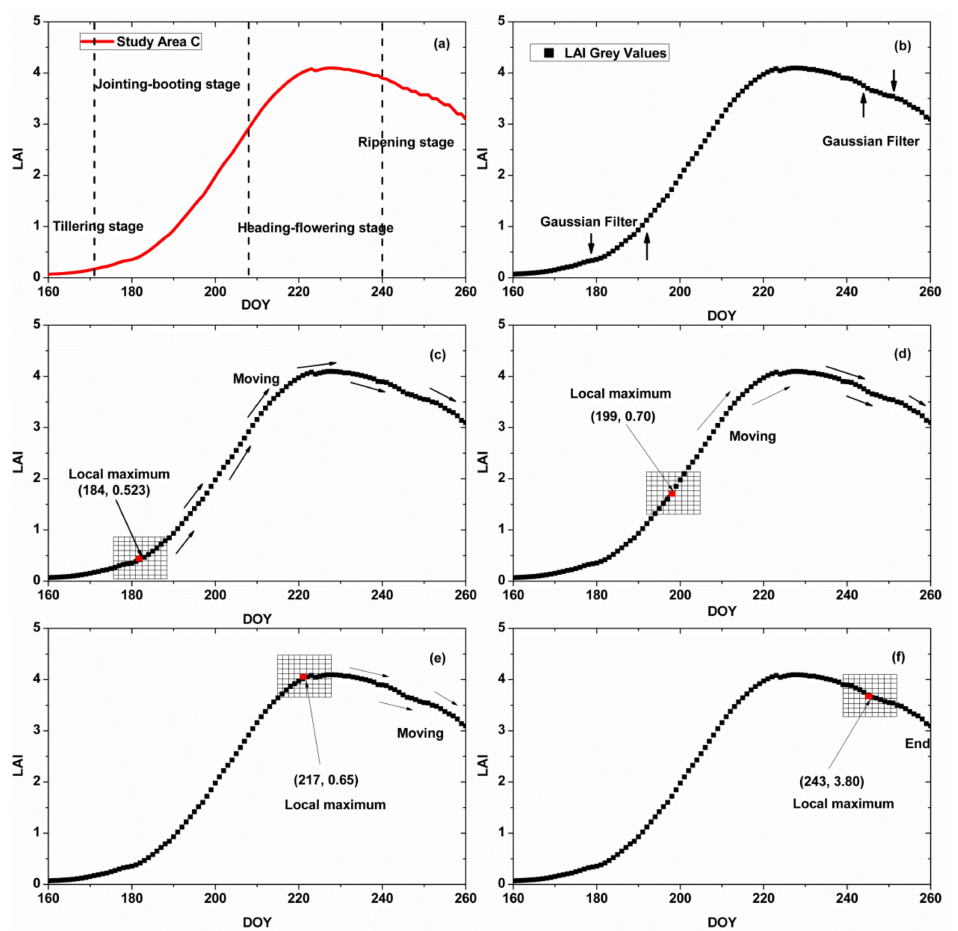
Figure 7. Process of the Harris algorithm of the LAI curve in study area C: ( a ) original LAI curve; ( b ) LAI curve with Gaussian filter; ( c – f ) process of searching for the dominant points in the LAI